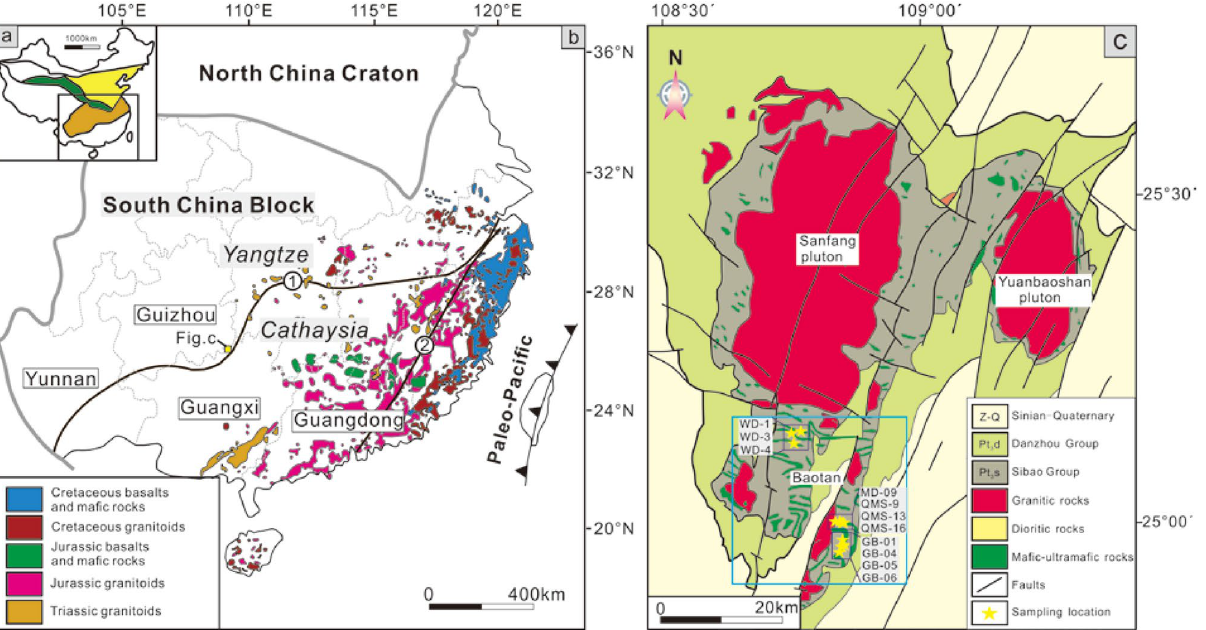
Figure 1. ( a ) Major tectonic units of China (modified from Ref. 5 ). ( b ) Simplified map showing the distributions of the Mesozoic magmatism in SCB (modified from Ref. 5 ). ① Qinzhou-Hangzhou belt, ② Zhenghe-Dapu fault zone. ( c ) Geological map of the northern Guangxi region showing the distribution of granites and mafic– ultramafic rocks with sample locations (modified from Ref. 6